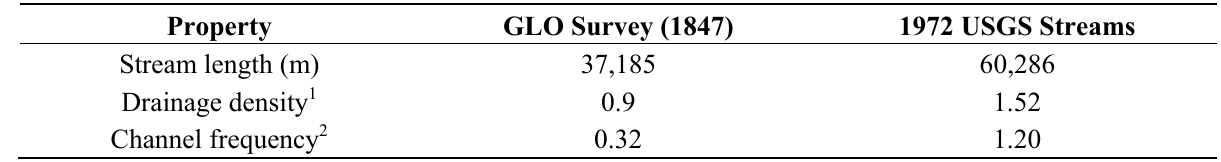
Table 1. Comparison of morphological characteristics of Walnut Creek in 1847 and 1972